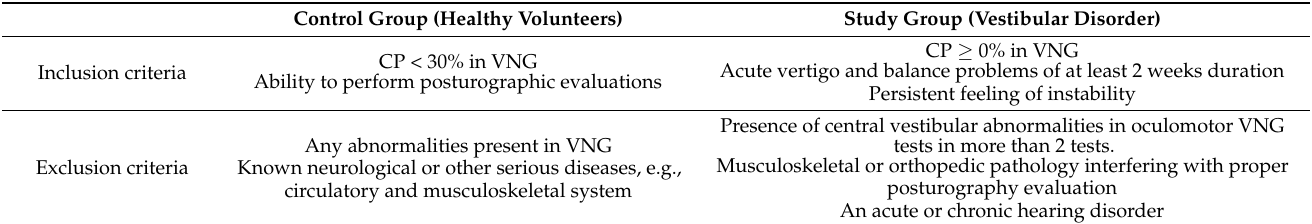
Table 1. Inclusion and exclusion criteria for recruitment to study and control groups.